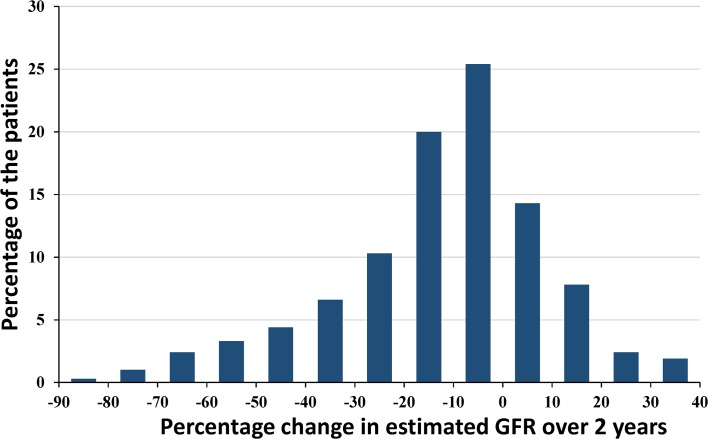
Distribution of percentage change in estimated GFR over 2 years.Percentage changes in estimated GFR were calculated with two measurements of serum creatinine at entry and after 2 years. The data show near normal distribution. The patients showing “rapid progression” defined as 50% decline over 2 years are observed in 7% of the total patients.